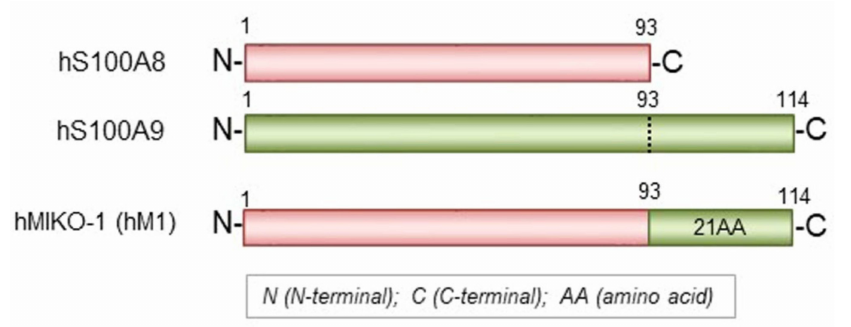
Figure 5. The whole frame of hMIKO-1. Full-length amino acid (AA) sequences of hS100A8 and hS100A9 are schematically represented by horizontal bars. The hMIKO-1 frame was as follows: 21 AA residues from the C-terminus of hS100A9 were added to the C-terminus of